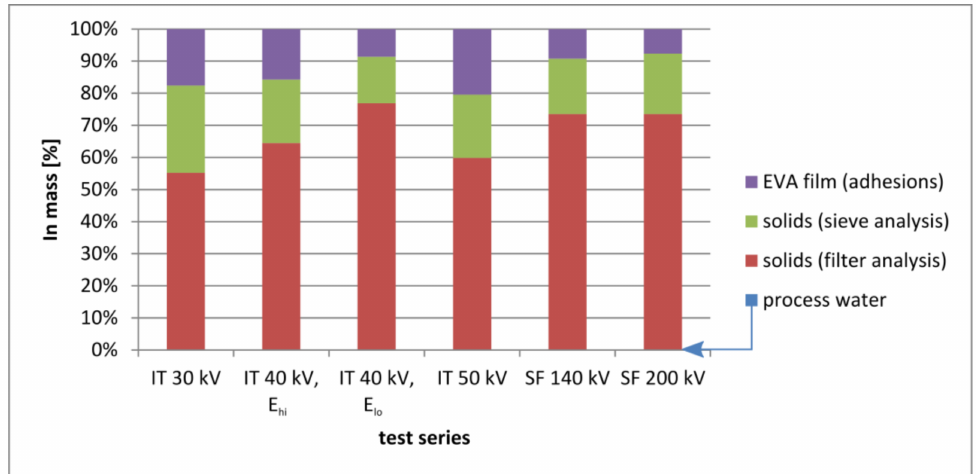
Figure 7. Distribution of indium mass of individual test series. Low values for process water of 0.1–0.2% not visible.